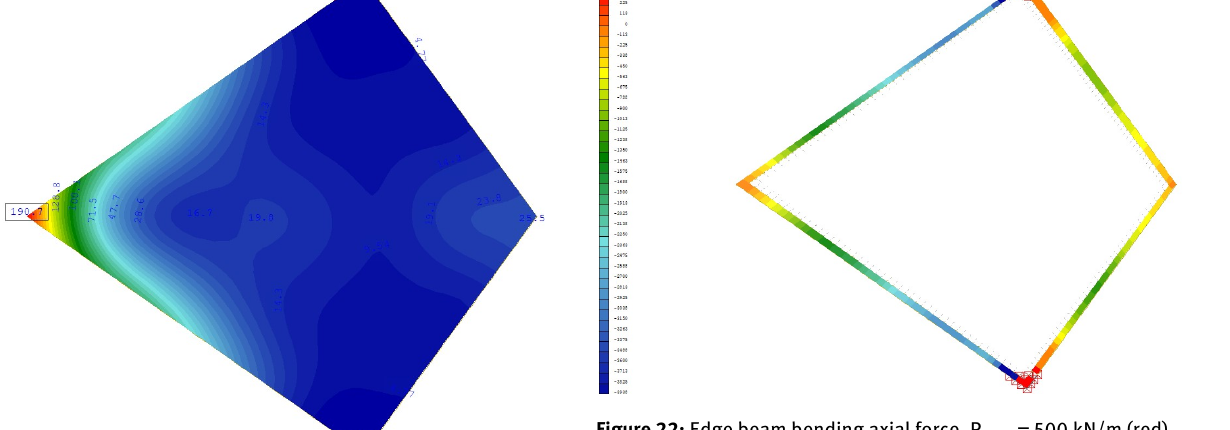
Figure 22: Edge beam bending axial force, P max = 500 kN/m (red) and V min = − 2930 kN/m (blue) 10 MPa around the hypar tip (close to point B) the top